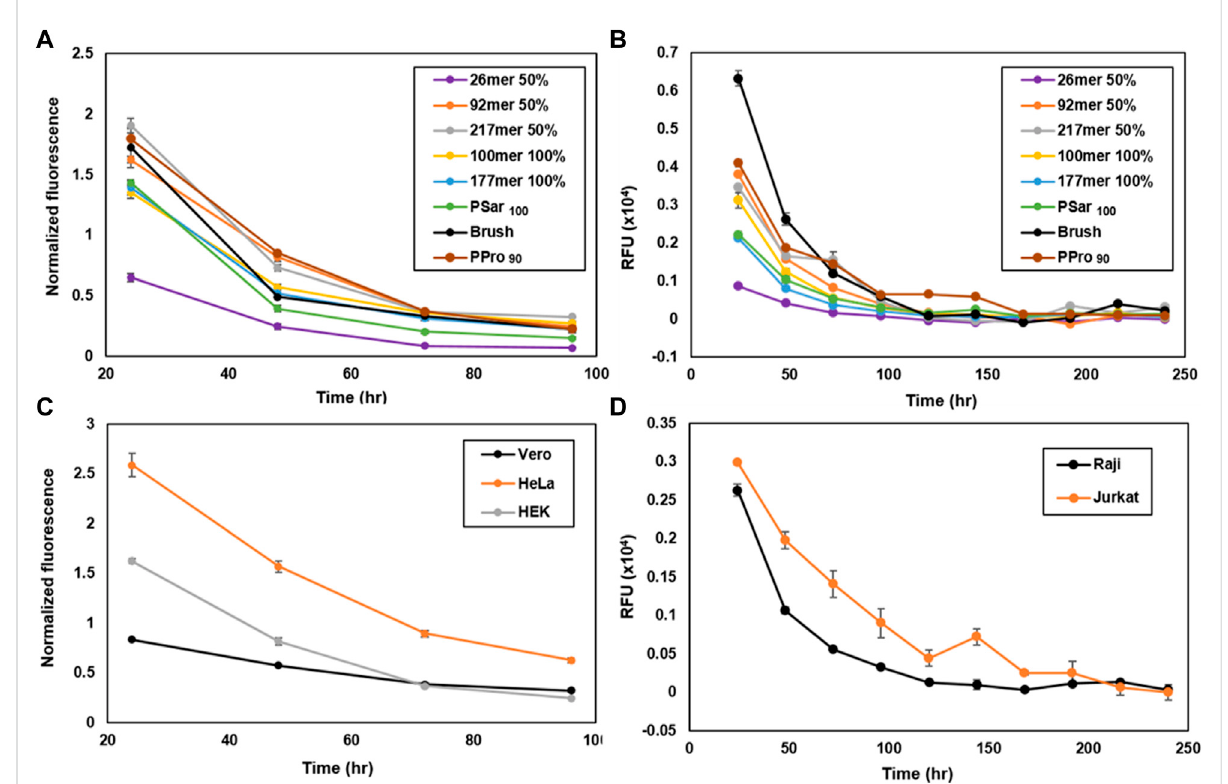
FIGURE 3 Engineered glycocalyx persistence time considering various synMUC structures and a variety of cell types. Persistence of the synMUC panel in (A) HEK cells and (B) Raji cells. Data in (A) was collected via fl uorescence microscopy, analyzed using ImageJ software, averaged with standard error for n = 2, and normalized against bright fi eld images to account for cell density. Data in (B) was collected via fl ow cytometry. Data are averages of medians calculated after gating for live, singlet cells and associated standard error, and were collected in duplicate. (C) Persistence of 50% glycosylated 92mer synMUC in three adherent (HEK, HeLa, Vero) cell lines. Data was collected as noted for (A) . (D) Persistence of 50% glycosylated 92mer synMUC in two suspension (Raji, Jurkat) cell lines. Data was collected as noted for (B)